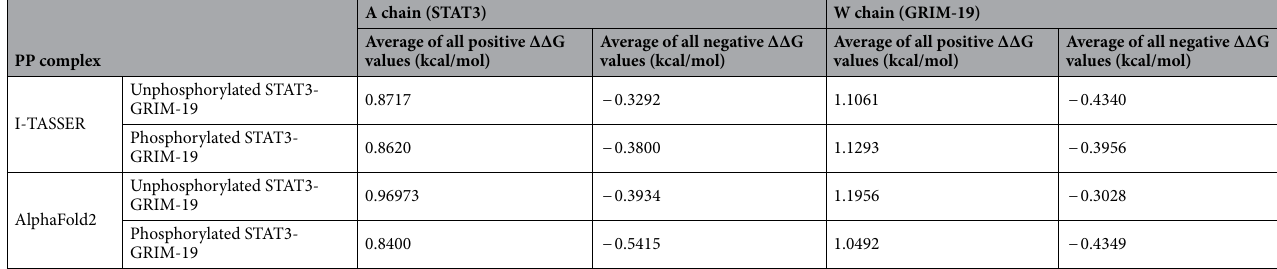
Table 4. Average of all positive and negative binding free energy change (ΔΔG) values of interface residues involved in hydrogen bonding upon mutation to all other amino acids using